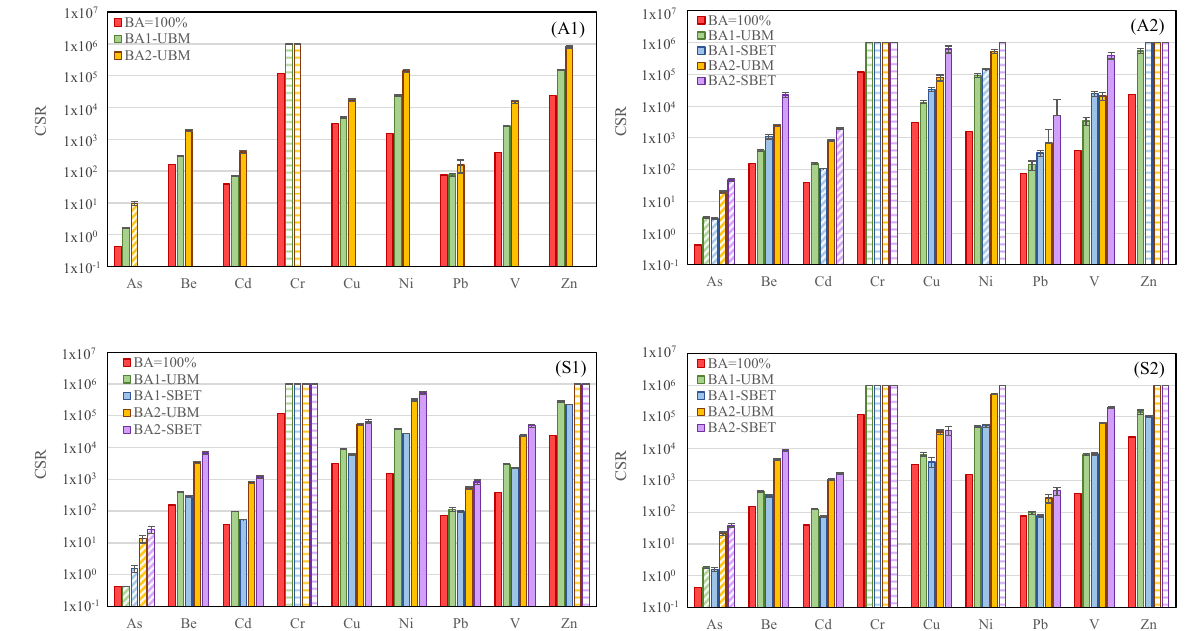
Figure 5. Comparison of the cleanup goals (CSR) calculated for each soil sample ( A1 , A2 , S1 , and S2 ) using the different bioaccessibility BA 1 and BA 2 or considering a 100% bioaccessibility. The striped bars indicate that the normalized cleanup goals were at least higher than the reported value, whereas the bars with horizontal strips indicate that the cleanup goal was higher than 10 6 .